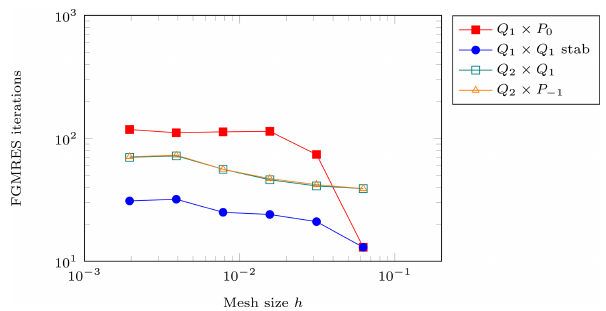
Figure 6. SolCx benchmark. Number of FGMRES solver iterations as a function of the mesh size h